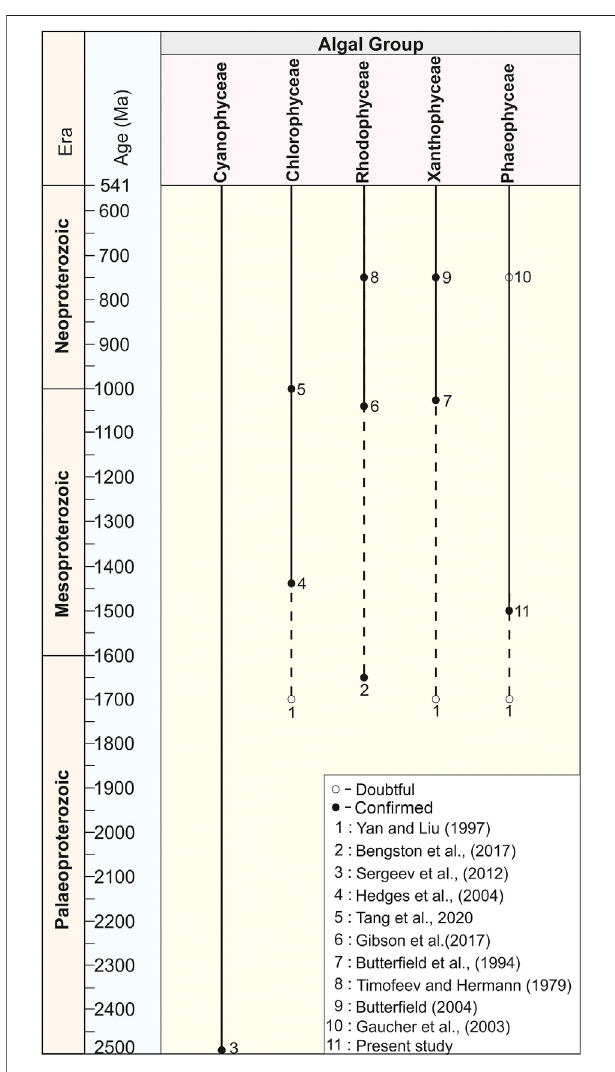
FIGURE 10 | Chart showing the antiquity of higher algae in Proterozoic time span compiled on the basis of published records.